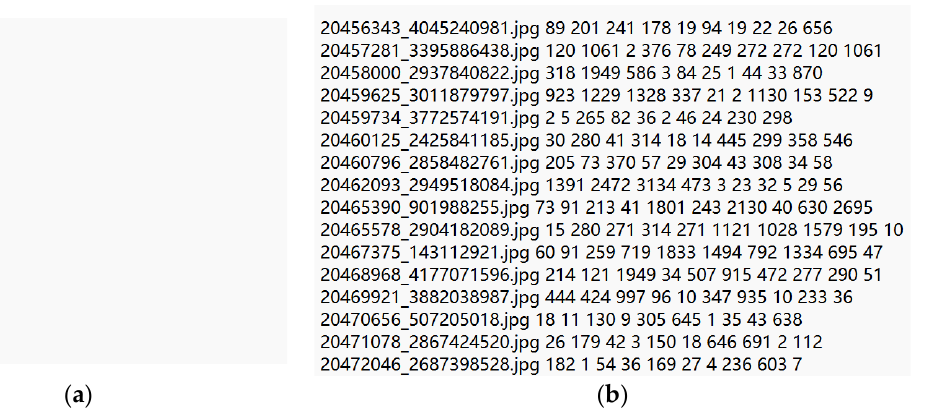
( b ) Figure 11. Training results of CRNN: ( a ) change in loss value and ( b ) variation in accuracy of vali- dation datasets.